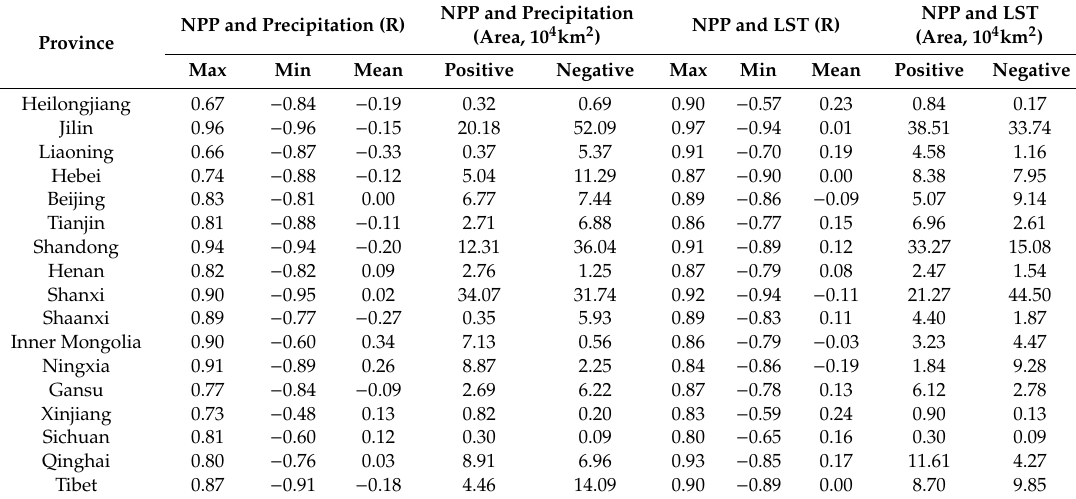
Table 2. The statistical results of the second-order partial correlation between NPP, precipitation, and